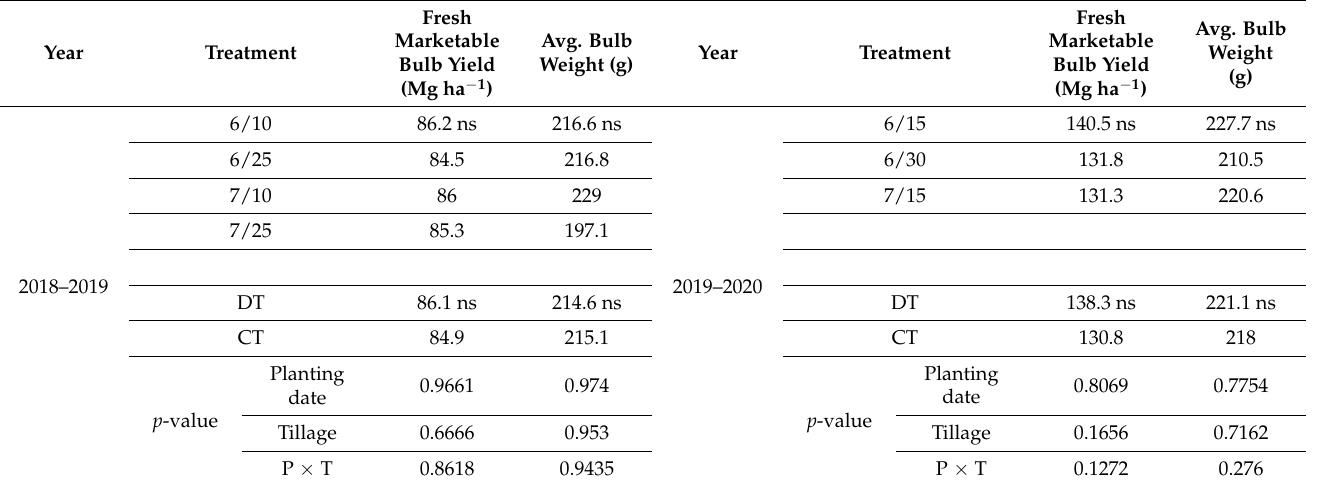
Table 13. Yield components of onion, as affected by the planting date and tillage practice on summer crops (deep tillage, DT; conventional tillage,